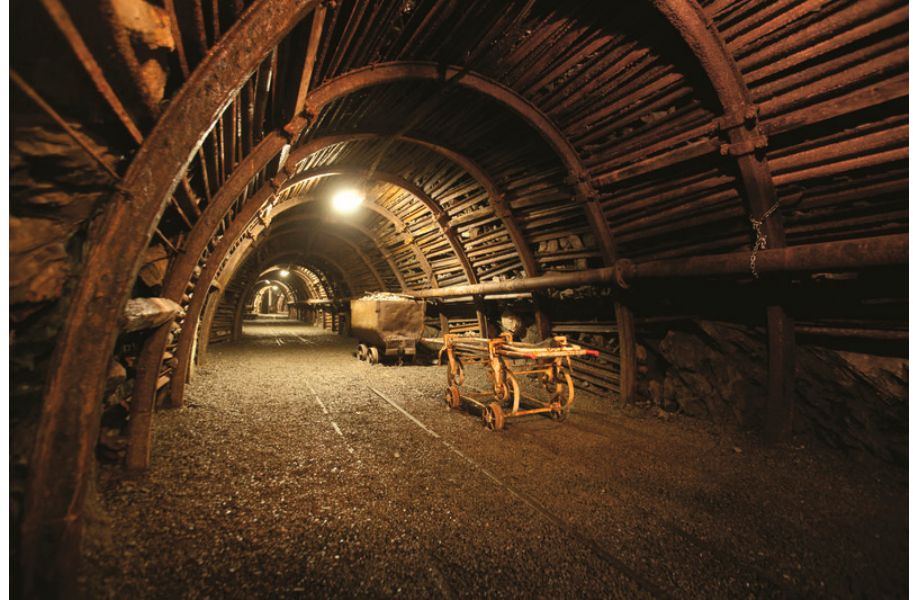
Figure 12. The underground operation area of Blegny-Mine.